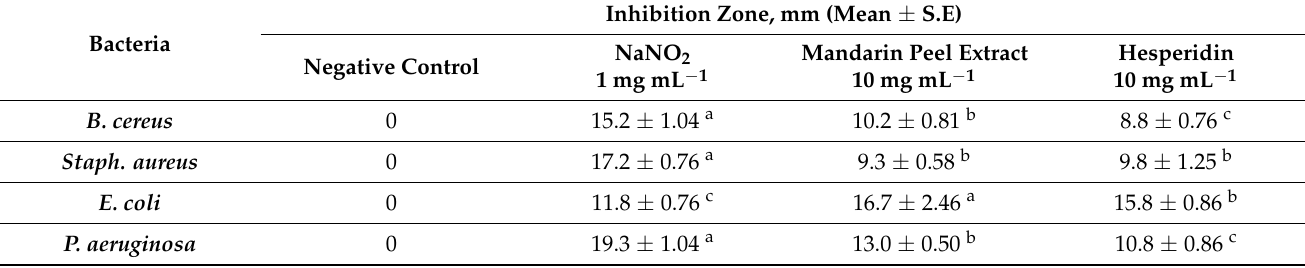
Table 3. Antibacterial activity of mandarin peel extract, hesperidin, and sodium nitrite against some foodborne pathogenic